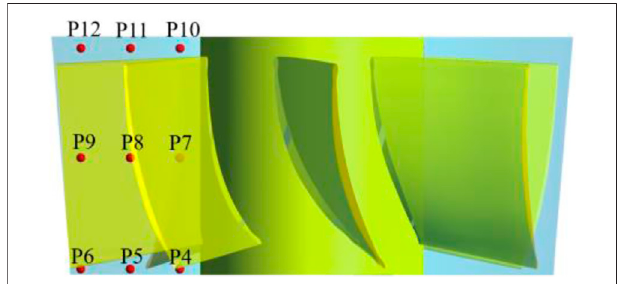
FIGURE 17 | Location of monitoring points of guide